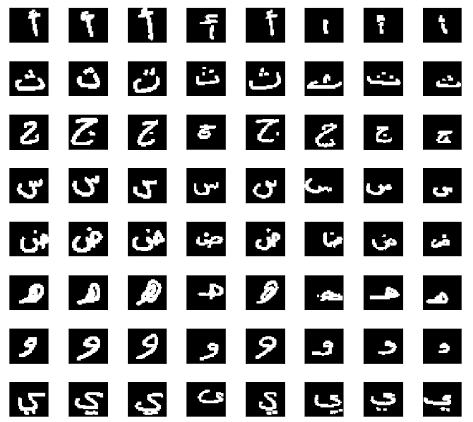
Figure 5. The Arabic MNIST dataset. The second dataset [3] comprises 16,800 characters written by 60 participants. The images were scanned at a resolution of 300 dpi. Each image was segmented automatically using MATLAB 2016a, which automatically coordinated every image. The database was then partitioned into 13,400 images for training and 480 images for testing, with 120 images per class, which sums up to 3360 images in